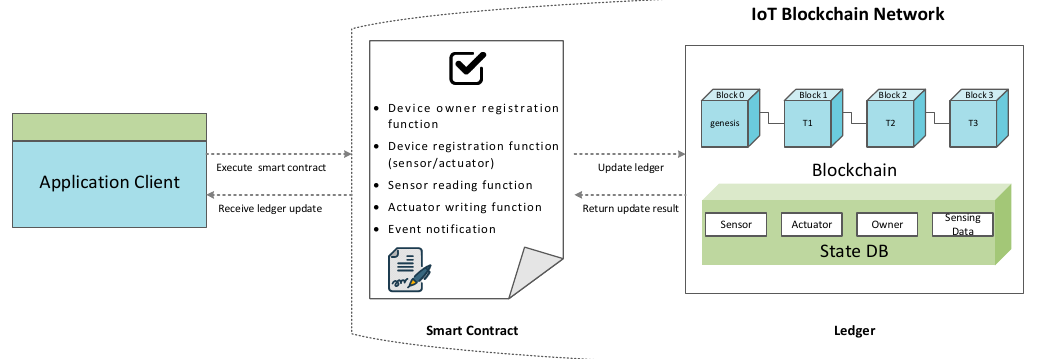
Figure 5 . Smart contract for IoT blockchain network interaction.